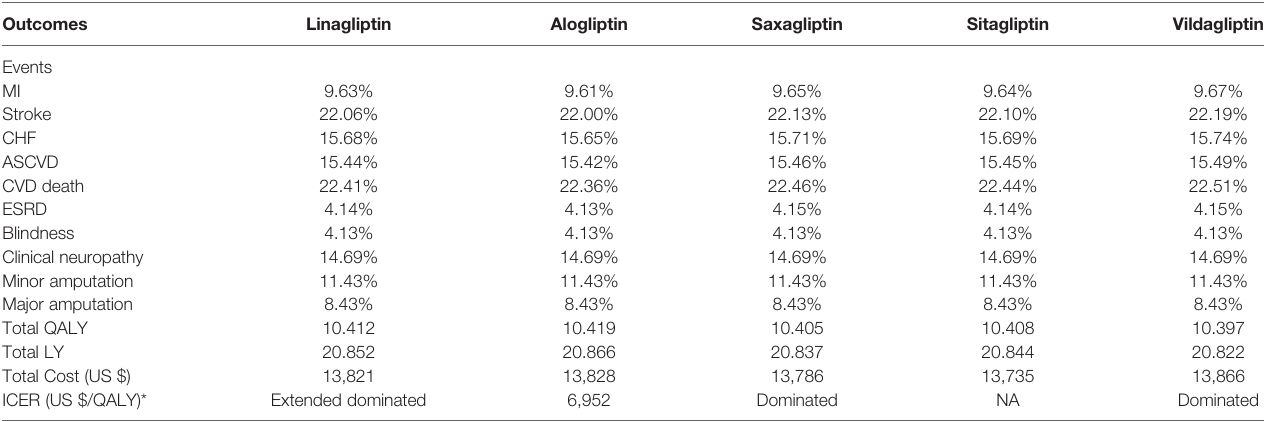
TABLE 2 | Base-case results for fi ve DDP-4 treatment strategies.